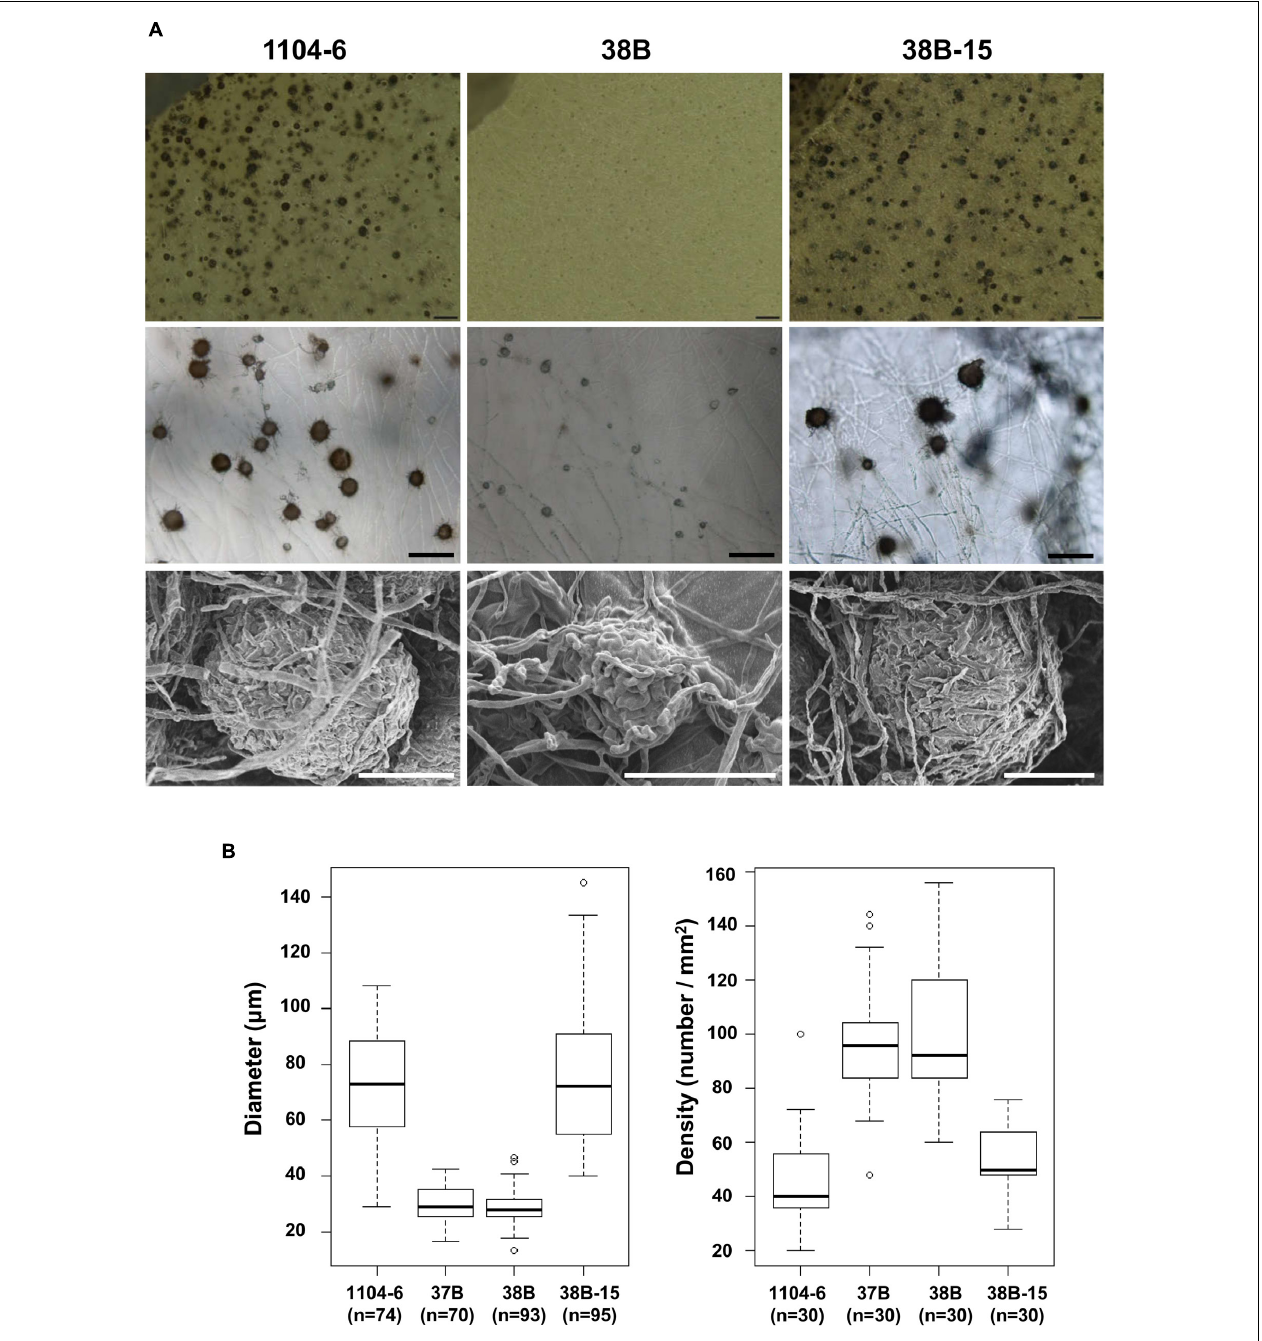
FIGURE 4 | The CfPMK1 gene is required for normal perithecium development. (A) Morphologies of perithecia formed by different strains. Top, dissecting microscopy of OA medium; middle, light microscopy of OA medium; bottom, scanning electron microscopy of PDA medium. The scale bar for light microscopy indicates 200 µ m whereas the scale bar for scanning electron microscopy indicates 50 µ m. (B) Boxplot showing variations of perithecial diameter and density among different strains.